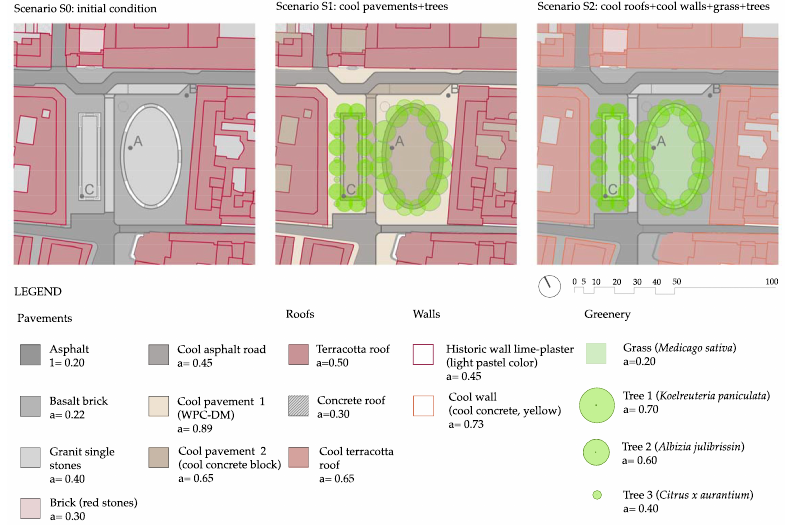
Figure 2. Initial condition scenario S0 ( a ), first renovation scenario S1 ( b ), second renovation scenario S2 ( c ). Point A, B and C represent the selected location for the comparisons among the